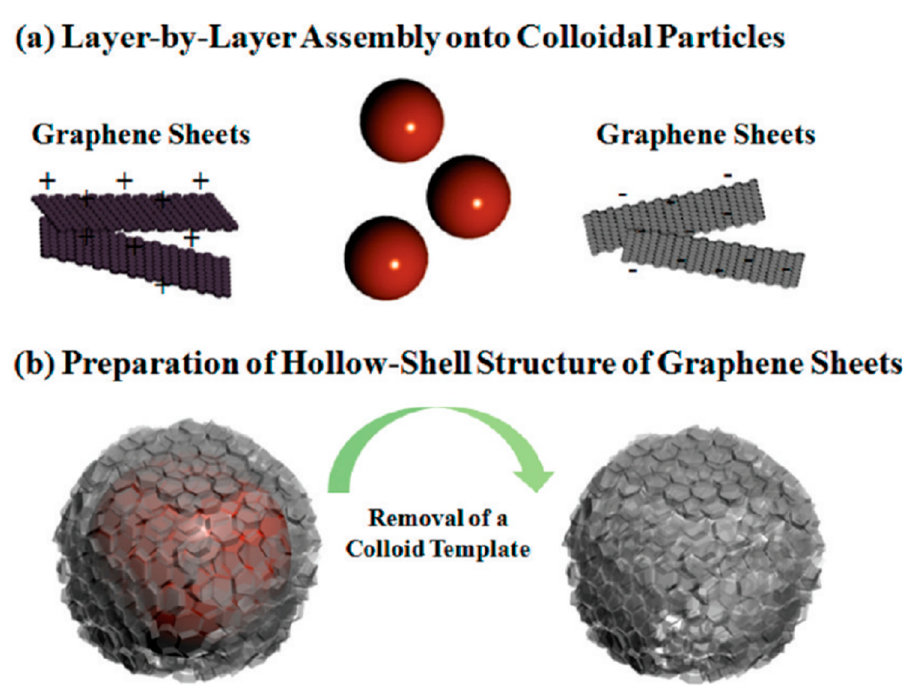
Figure 3. Schematic representation of rGO hollow capsules assembly. Republished with permission from Ref. [3]. Copyright 2022 American Chemical Society.